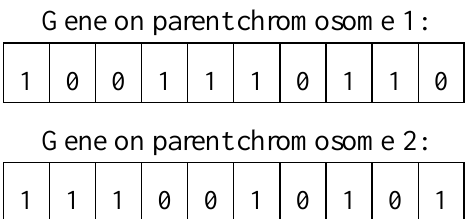
Figure 7. Chromosomes before uniform crossover.